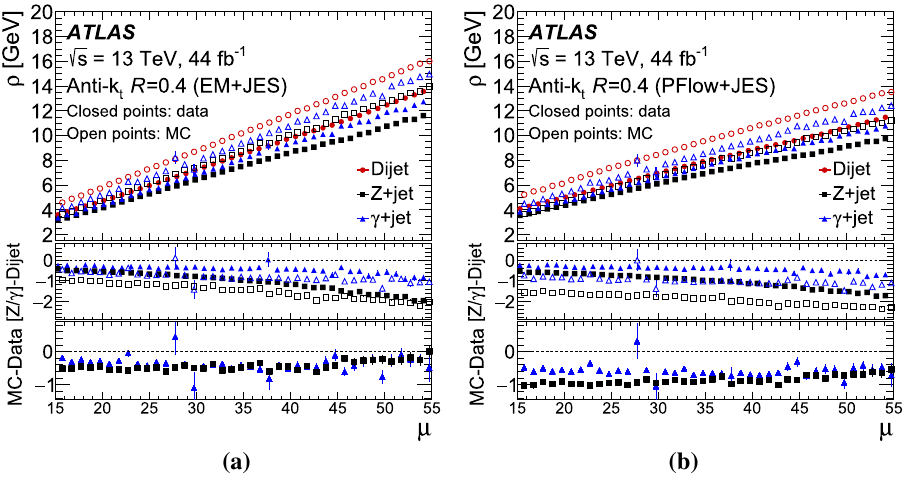
Fig. 18 Inputs to the ρ topology uncertainty derived in the Z +jet, γ +jet, and dijet in situ analyses. The error bars show the statistical uncertainties. The top panels relate the p T density ρ to the mean num- ber of interactions per bunch crossing μ in data and MC simulation for thethreeinputanalyses.Thesecondpanelsshowthedifferencebetween